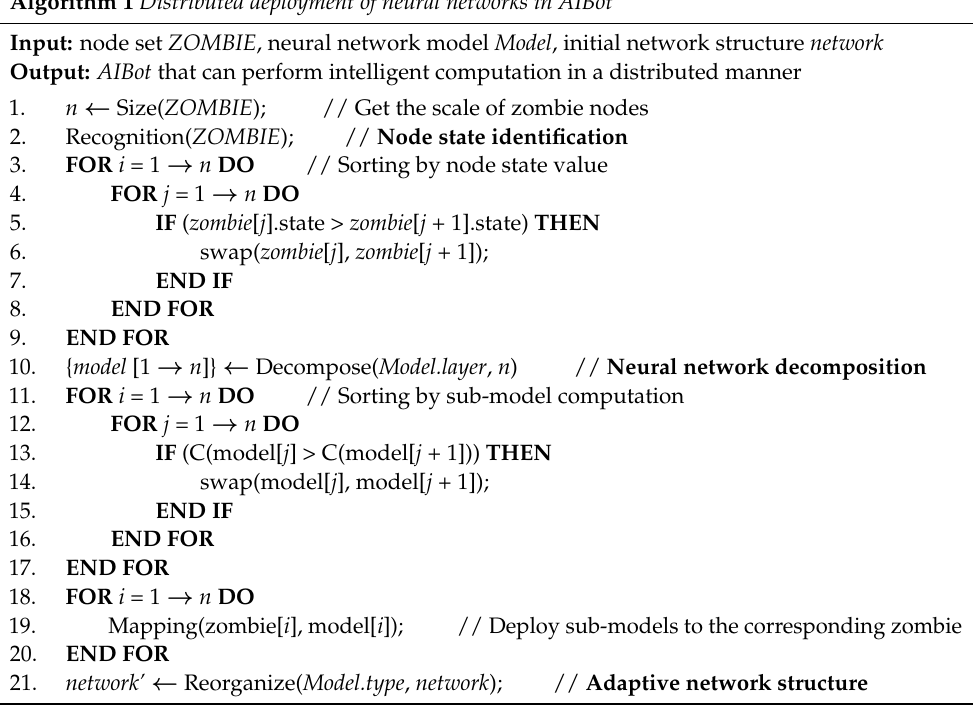
Algorithm 1 Distributed deployment of neural networks in